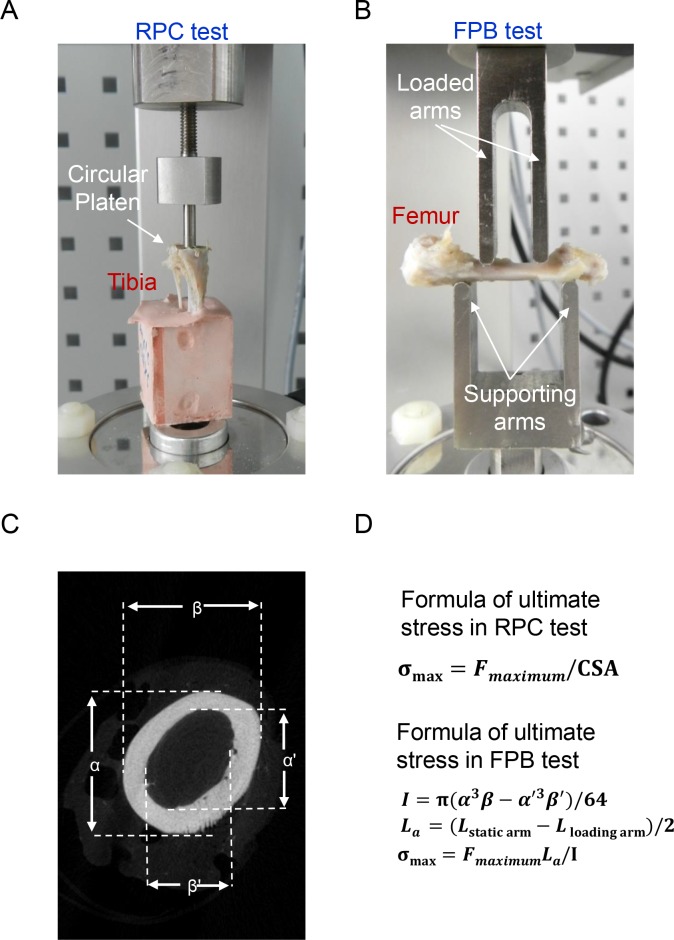
Biomechanical and tomographic methodologies.Male Wistar rats were subjected to sham operation or orchiectomy. After sacrifice, tibias and femurs from sham and orchiectomized rats were collected for analyses of mechanistic reduced-platen compression (RPC) and four-point bending (FPB) (A and B) as well as micro-computed tomography (μCT) (C). In the RPC test, the upper cortical shell of a tibia was removed in order to expose the trabecular region. The strength of trabecular bone was measured using a circular platen to compress the trabecular bone (A). In the FPB test, a femur was placed across two supporting arms and compressed by double loaded arms with a constant force until the specimen broke (B). The external (α and β) and internal (α' and β') diameters of the femur were measured by μCT in order to calculate the cross-sectional area (CSA) (C). The ultimate stress (σmax) in the RPC and FPB tests were calculated according to two different formulas (D). F
maximum, maximum force during loading history; I, area of inertia; Lα, distance between the supporting and loading pins; L
loading arm, length of the loading span; L
static arm, length of the supporting span.